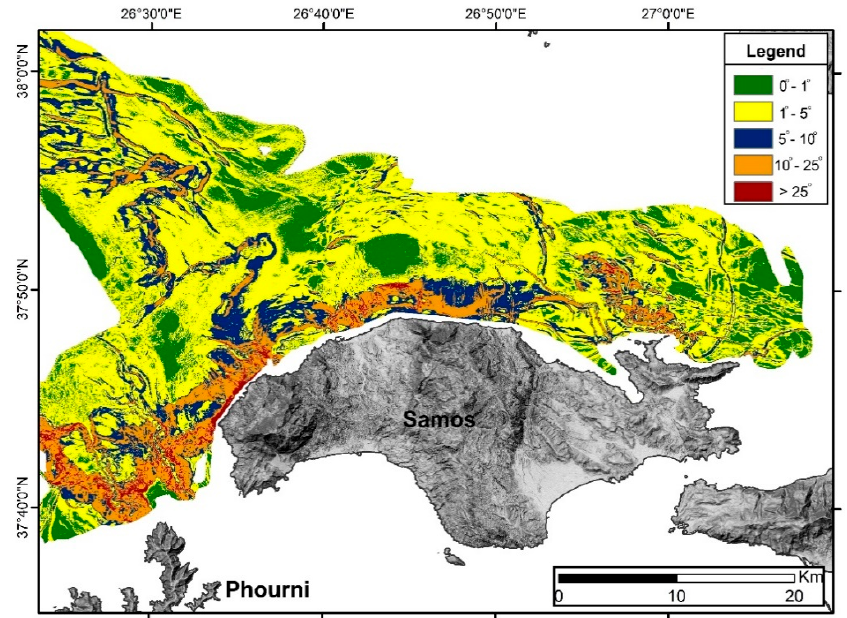
Figure 4. Morphological slope map of the studied area north of Samos Island.